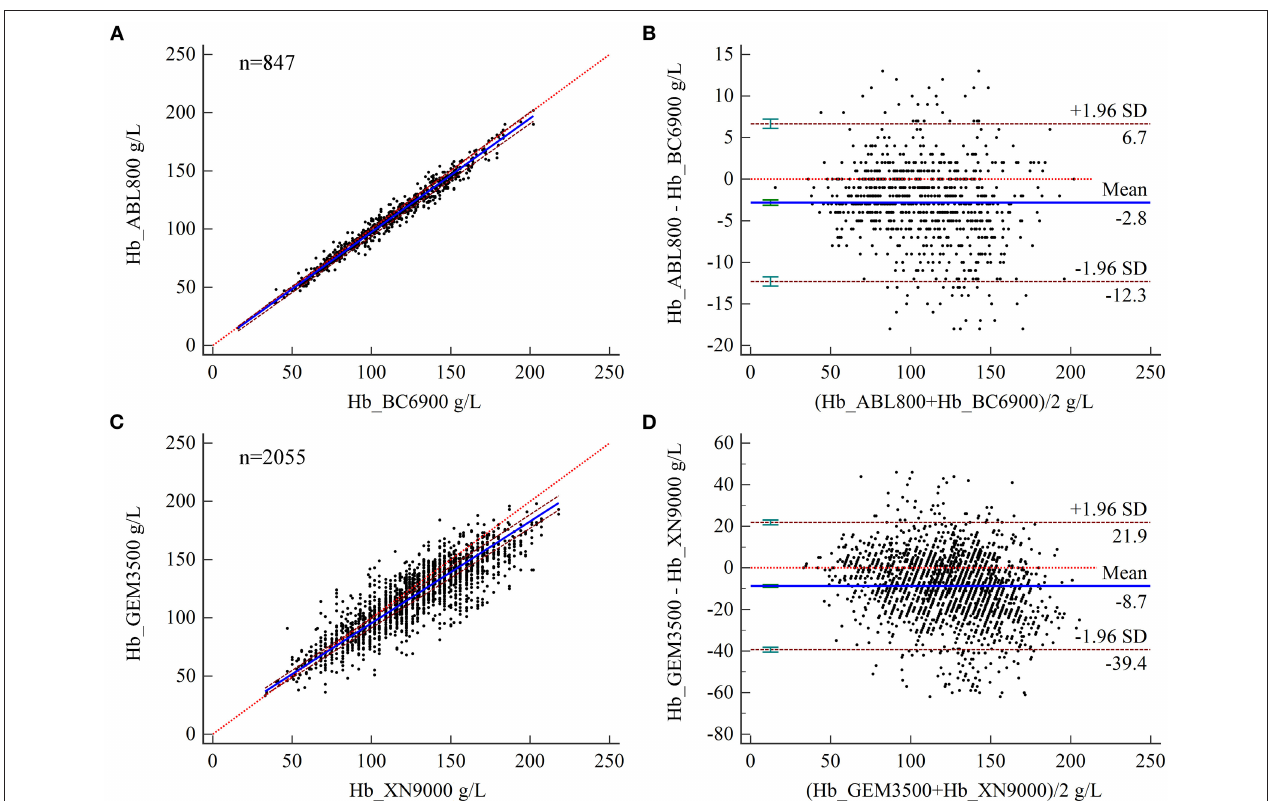
FIGURE 4 | (A,B) Scatter diagrams showing the results of Passing–Bablok regression analysis of the comparisons of hemoglobin (Hb) levels in arterial and venous blood samples between the ABL800 FLEX and BC-6900 systems (A) and between the GEM3500 and XN-9000 systems (B) . The graph shows the observations together with the regression line (solid blue line), the confidence interval for the regression line (dashed lines), and the identity line ( x = y , dotted line). (C, D) Results of Bland–Altman analysis of the comparisons of Hb levels in arterial and venous blood samples between the ABL800 FLEX and BC-6900 systems (C) and the GEM3500 and XN-9000 systems (D) , with 95% limits of agreement (LoA). The scatter diagram shows the differences plotted against the averages of the two measurements. Horizontal lines are drawn at the mean difference and the